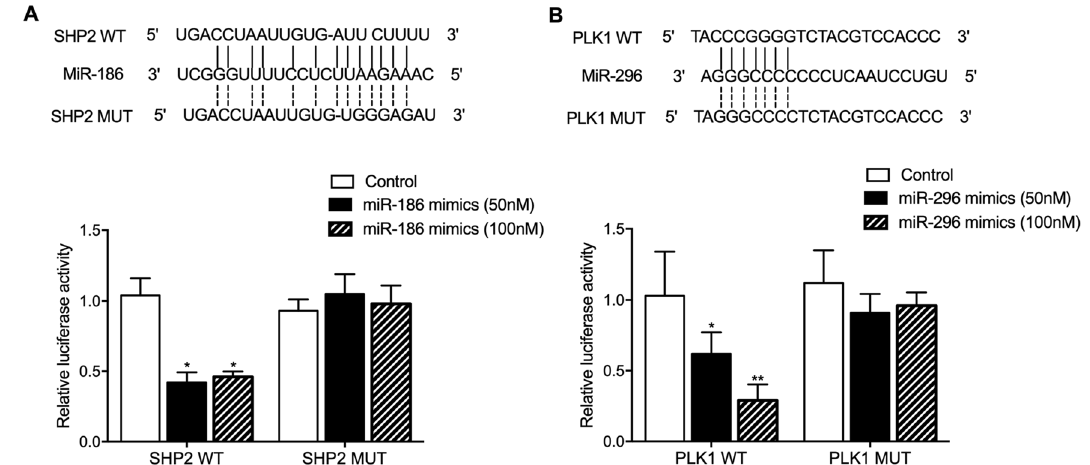
Figure 3. Computational analysis and luciferase assays validated the molecular relationships between miR- 186 and SHP2, and between miR-296-5p and PLK1. ( A ) The putative binding site of miR-186 on the 3 ′ UTR of SHP2 was identified, and the luciferase activity of wild-type SHP2 was significantly inhibited by the transfection of miR-186 mimics at both high and low dosages (*P value < 0.05 vs. control); ( B ) The putative binding site of miR-296-5p on the 3 ′ UTR of PLK1 was identified, and the luciferase activity of wild-type PLK2 was significantly inhibited by the transfection of miR-296 mimics in a dose-dependent manner (*P value < 0.05 vs.